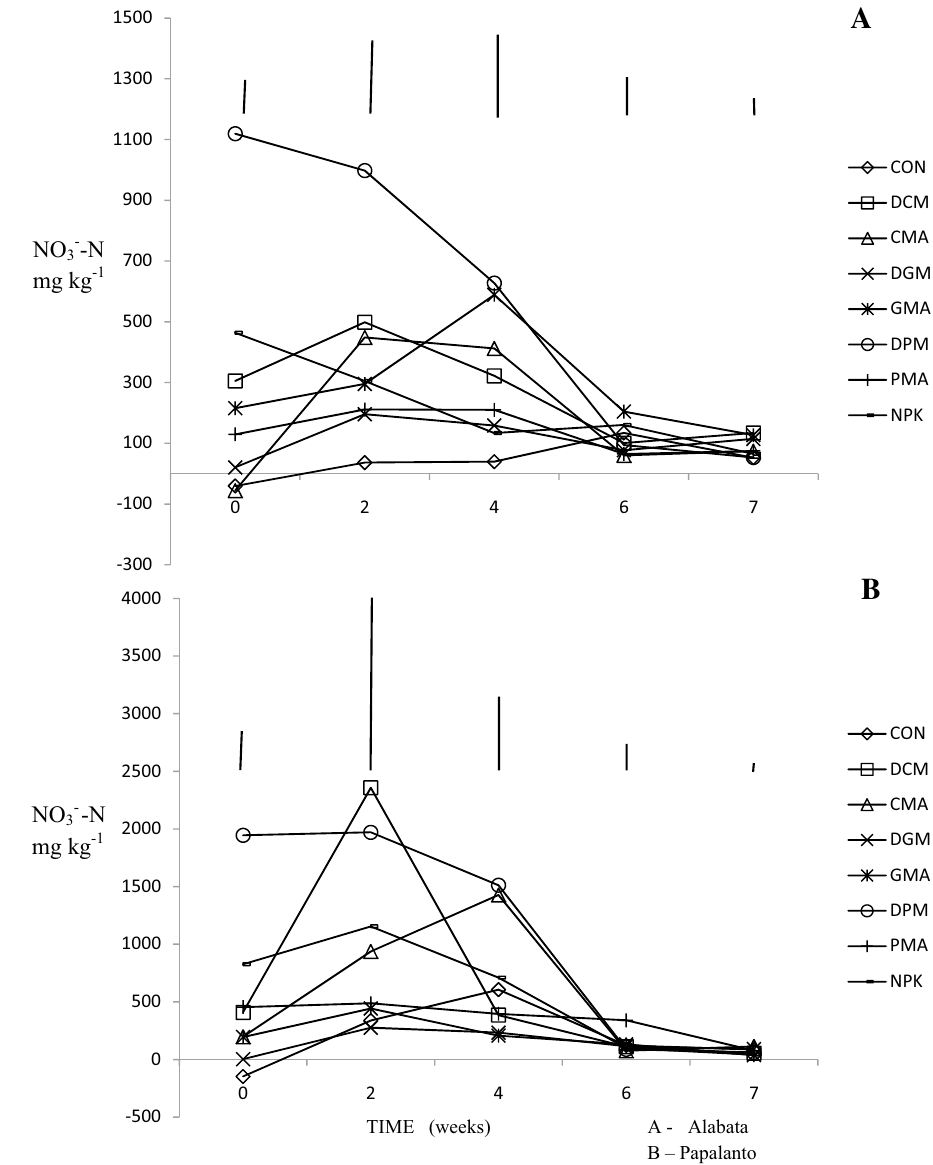
Fig. 7 Changes in soil nitrate nitrogen in screen-house (cycle